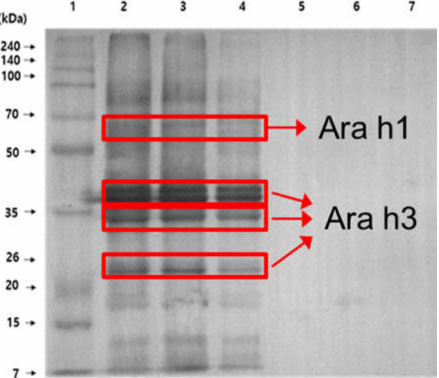
Figure 2. Western blot results. Lane 1: marker; lane 2: roasting peanut; lane 3: boiled peanut; lane 4: peanut butter; lane 5: almond; lane 6: cashew nut; lane 7: red